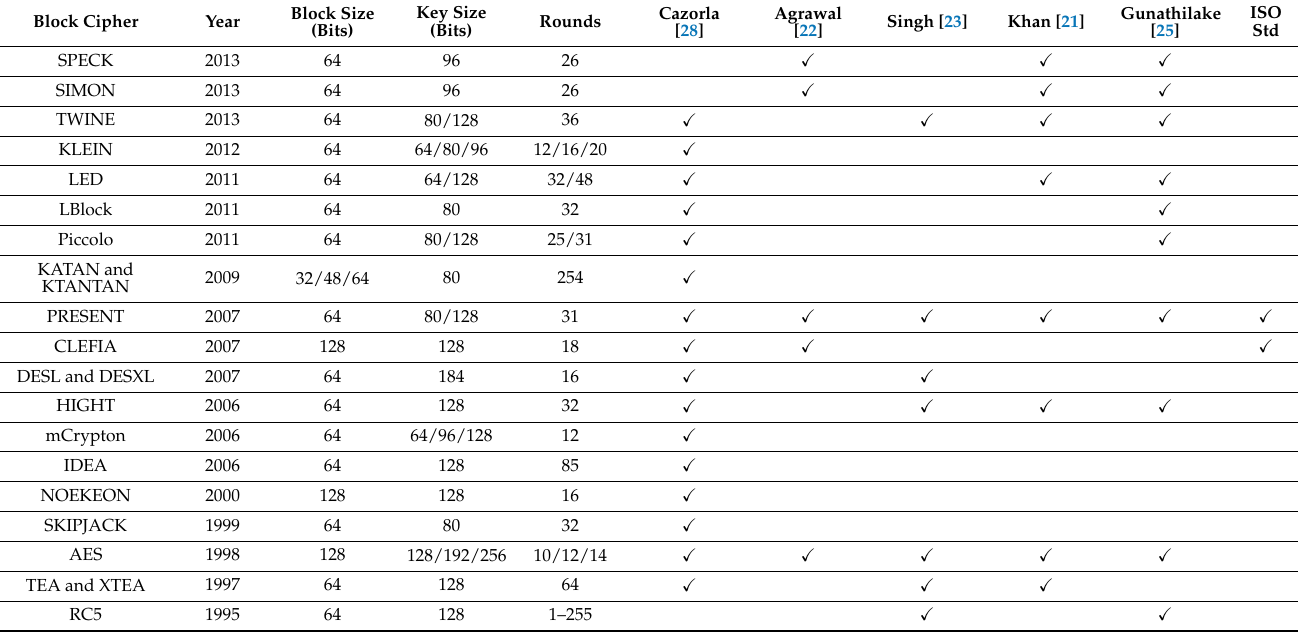
Table 4. Lightweight solutions for